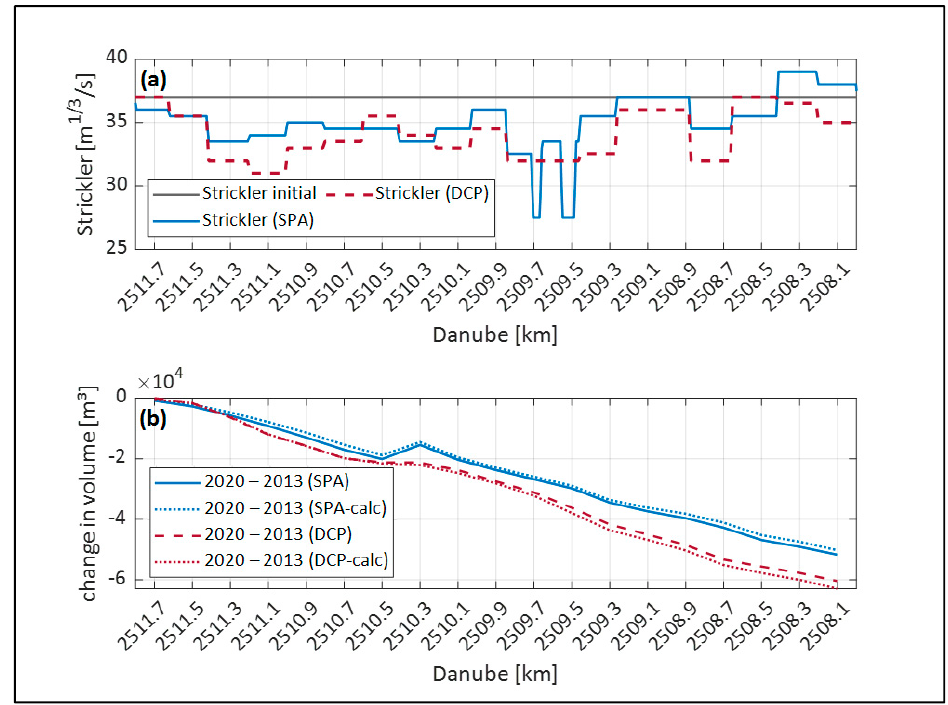
Figure 6. Initial Strickler values and calibrated Strickler values for SPA and DCP data ( a ) and a comparison of calculated and simulated cumulative change in volume ( b ).